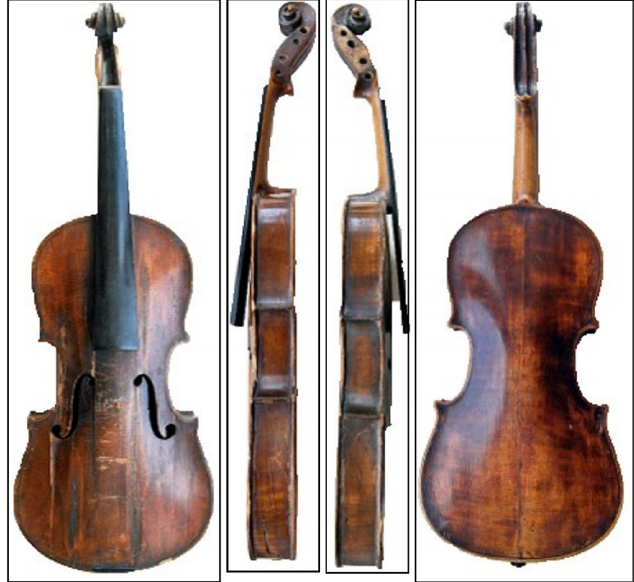
Figure 1. The body of the violin (front, sides and back).